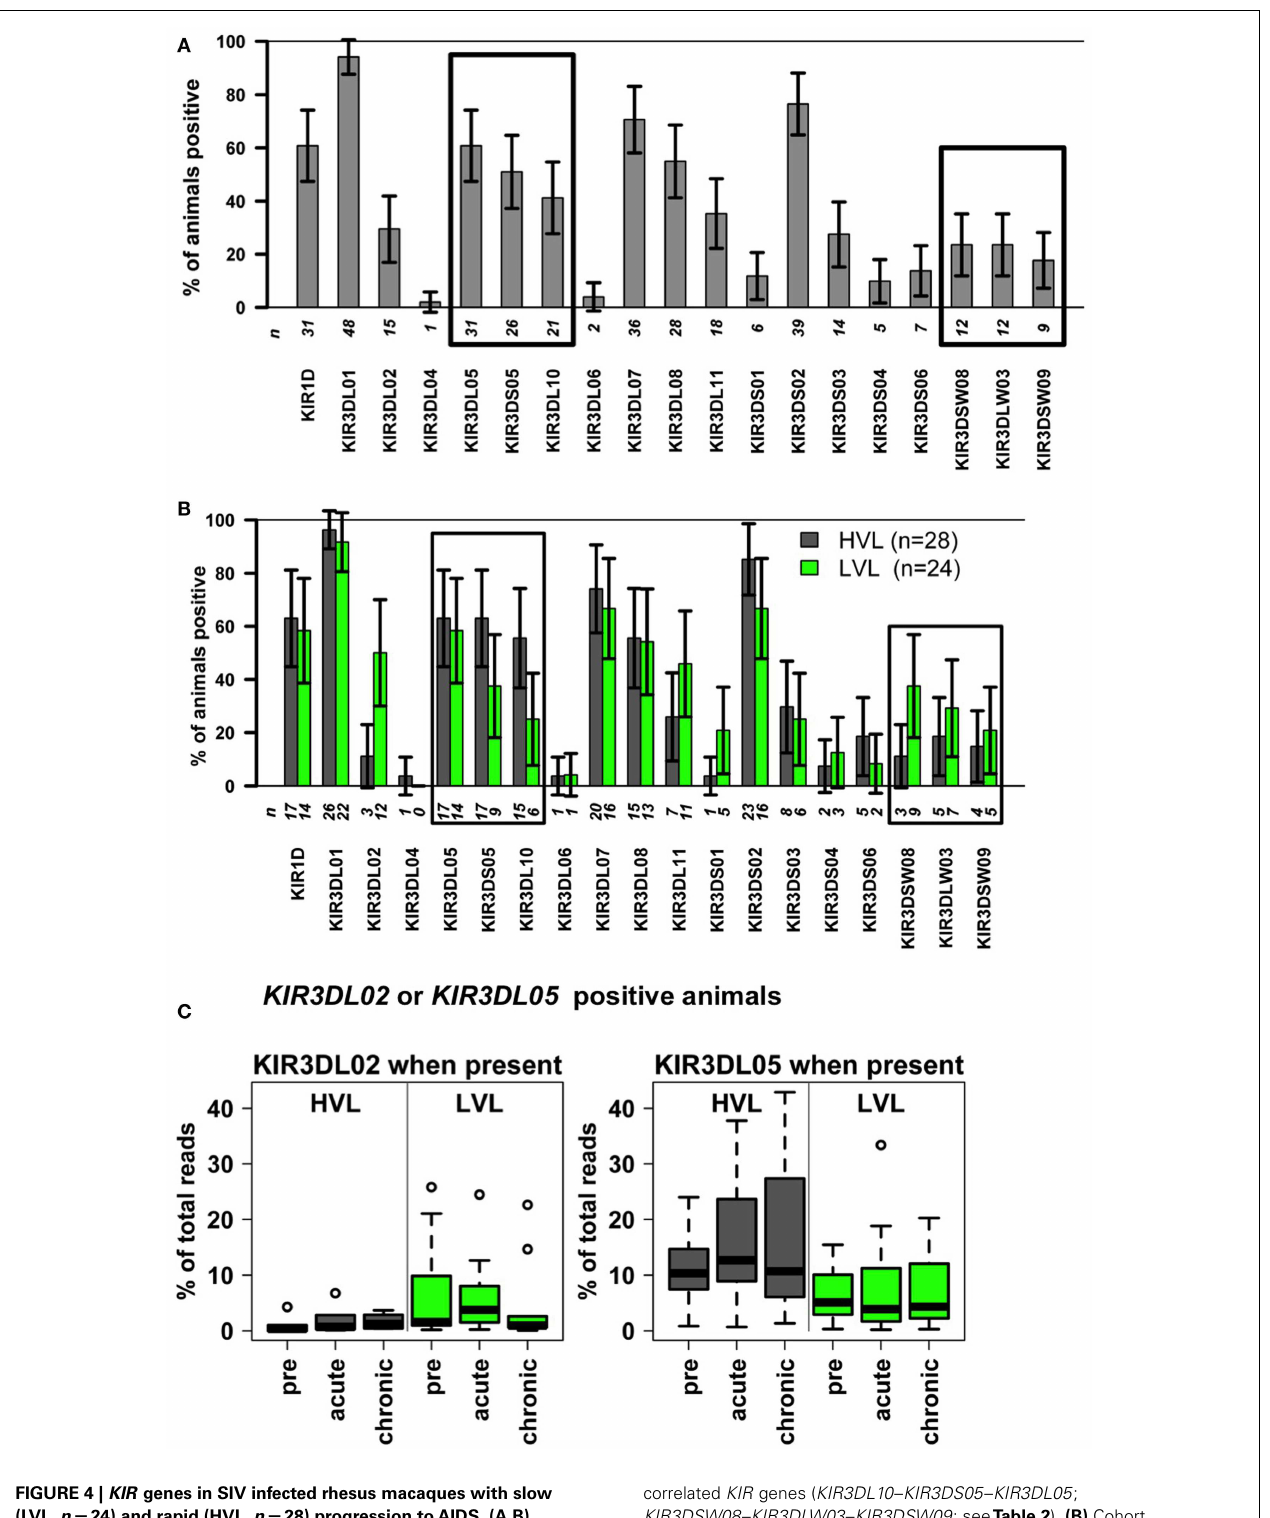
FIGURE 4 | KIR genes in SIV infected rhesus macaques with slow (LVL, n = 24) and rapid (HVL, n = 28) progression toAIDS . (A,B) Relative percentage of animals displaying the KIR transcript (bar height) with 95% confidence limits (error bars).The number n of animals transcribing the respective KIR gene is given below the bars. (A) Complete cohort of n = 52 rhesus macaques. Boxes indicate